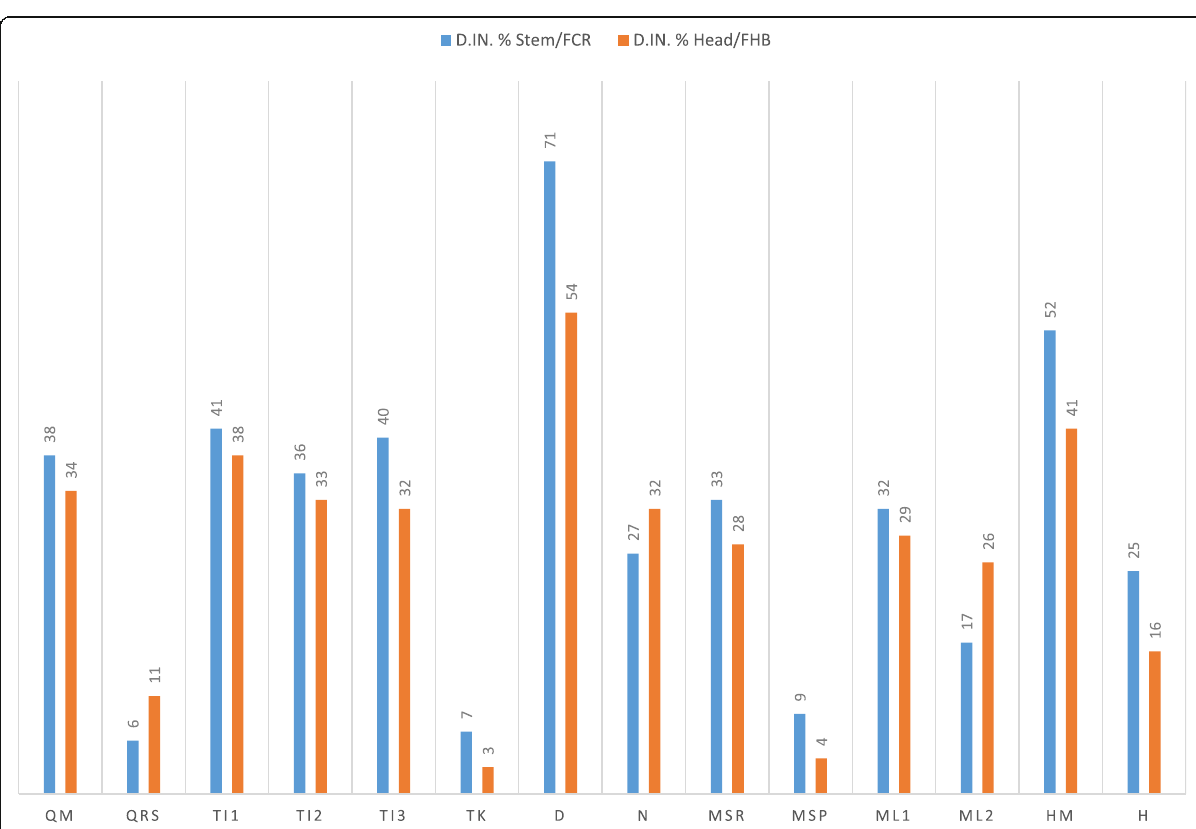
Fig. 1 The percentage of FHB and FCR disease incidence of wheat in the 14 selected fields in the south of Basra province during